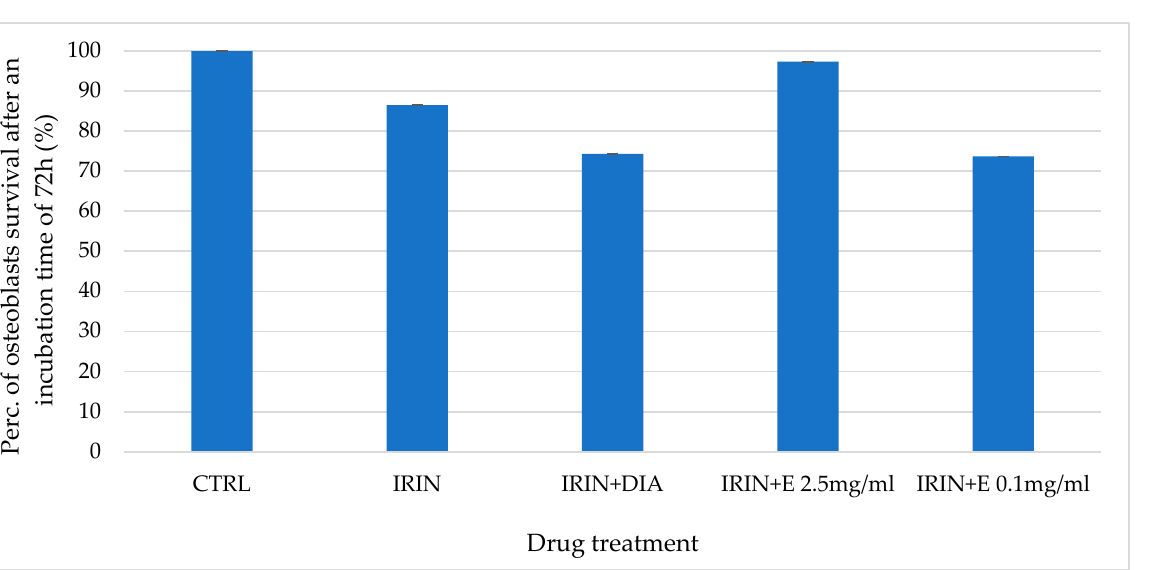
Figure 1. Percentage of cell growth values of osteoblasts co-incubated with two different drugs such as doxorubicin (DOXO) and dexamethasone (DEXA), each drug and diazoxide (DIA), and each drug and various concentrations of the extract (E) measured using the crystal violet assay, compared to controls (CTRL). Data are shown for two different concentrations of the extract (2.5 mg/mL and 0.1 mg/mL) after 0 h, 24 h, 48 h, and 72 h of incubation, using the drug doxorubicin in the orange lines and dexamethasone in the green lines. One-way ANOVA testing for differences between and within groups of treatments showed significant differences between treatments (F > 2 and p < 0.005) at different incubation times for DOXO and DOXO + E 2.5, and DEXA after 72 h and DEXA + E 2.5 (N experiments = 6).